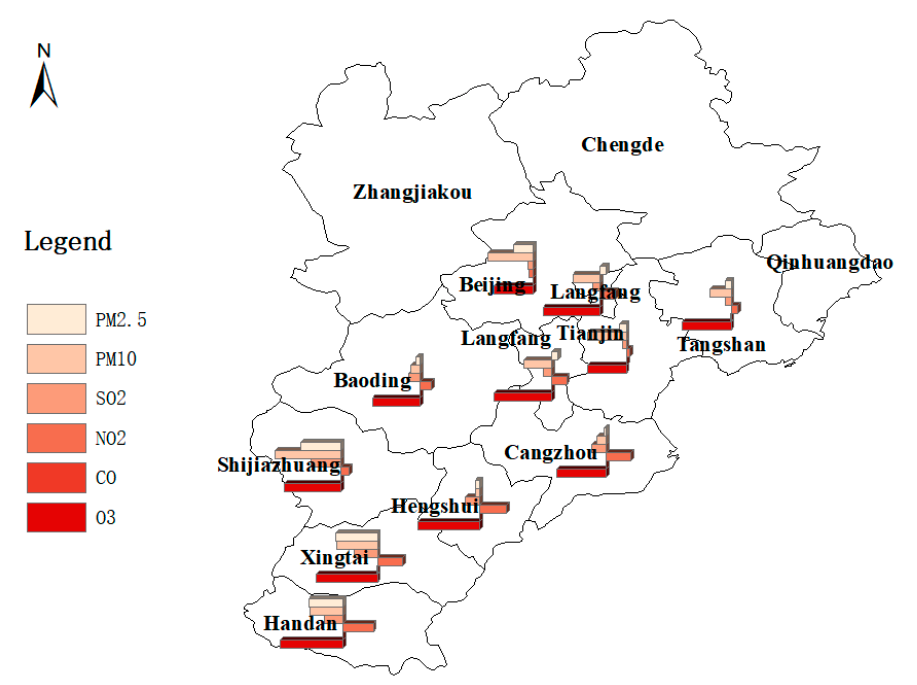
Figure 5. Estimation results of the BSDW policy on different